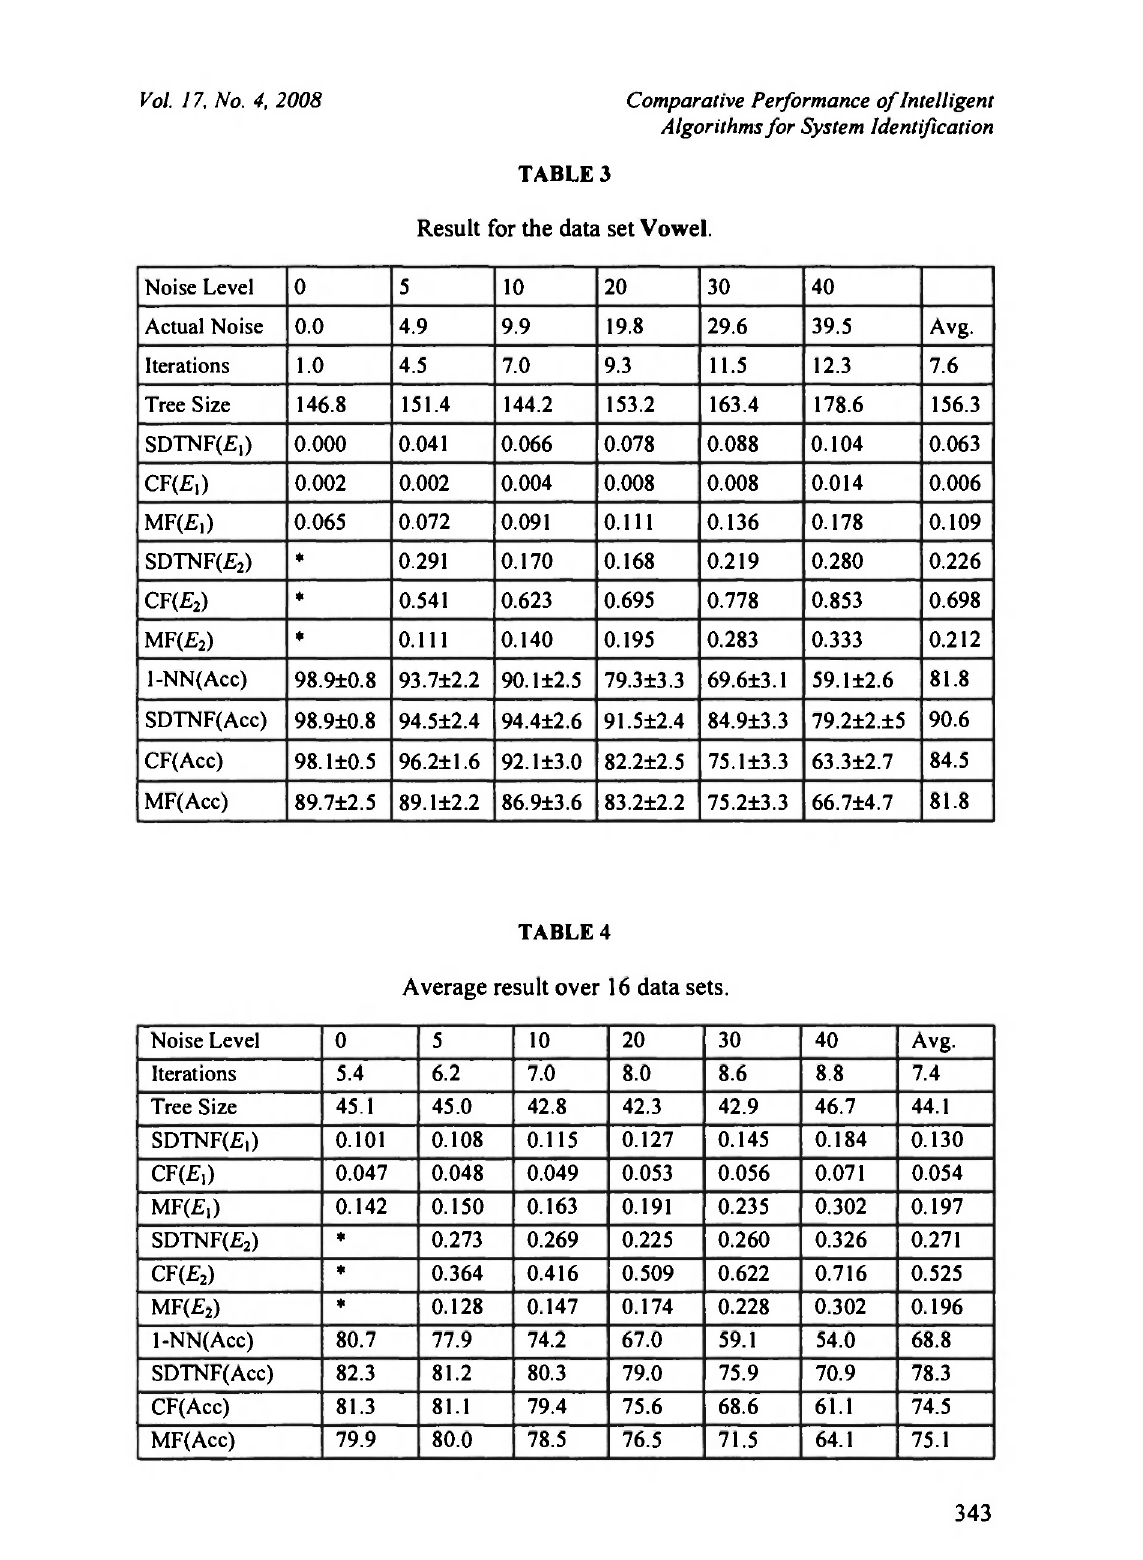
Result for the data set Vowel.